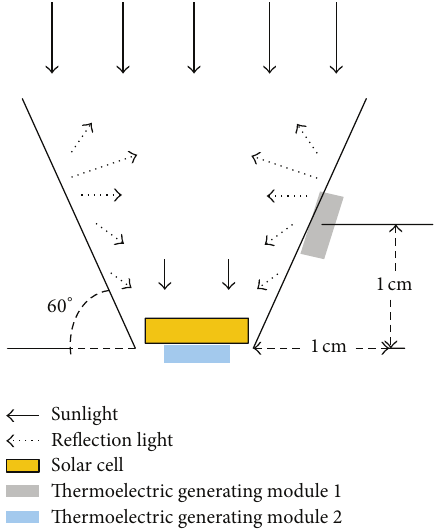
Figure 6: Schematic diagram of the thermoelectric generating modules placed at the backside of the optical rod prism and the bottom side of the GaAs solar cell in this research.